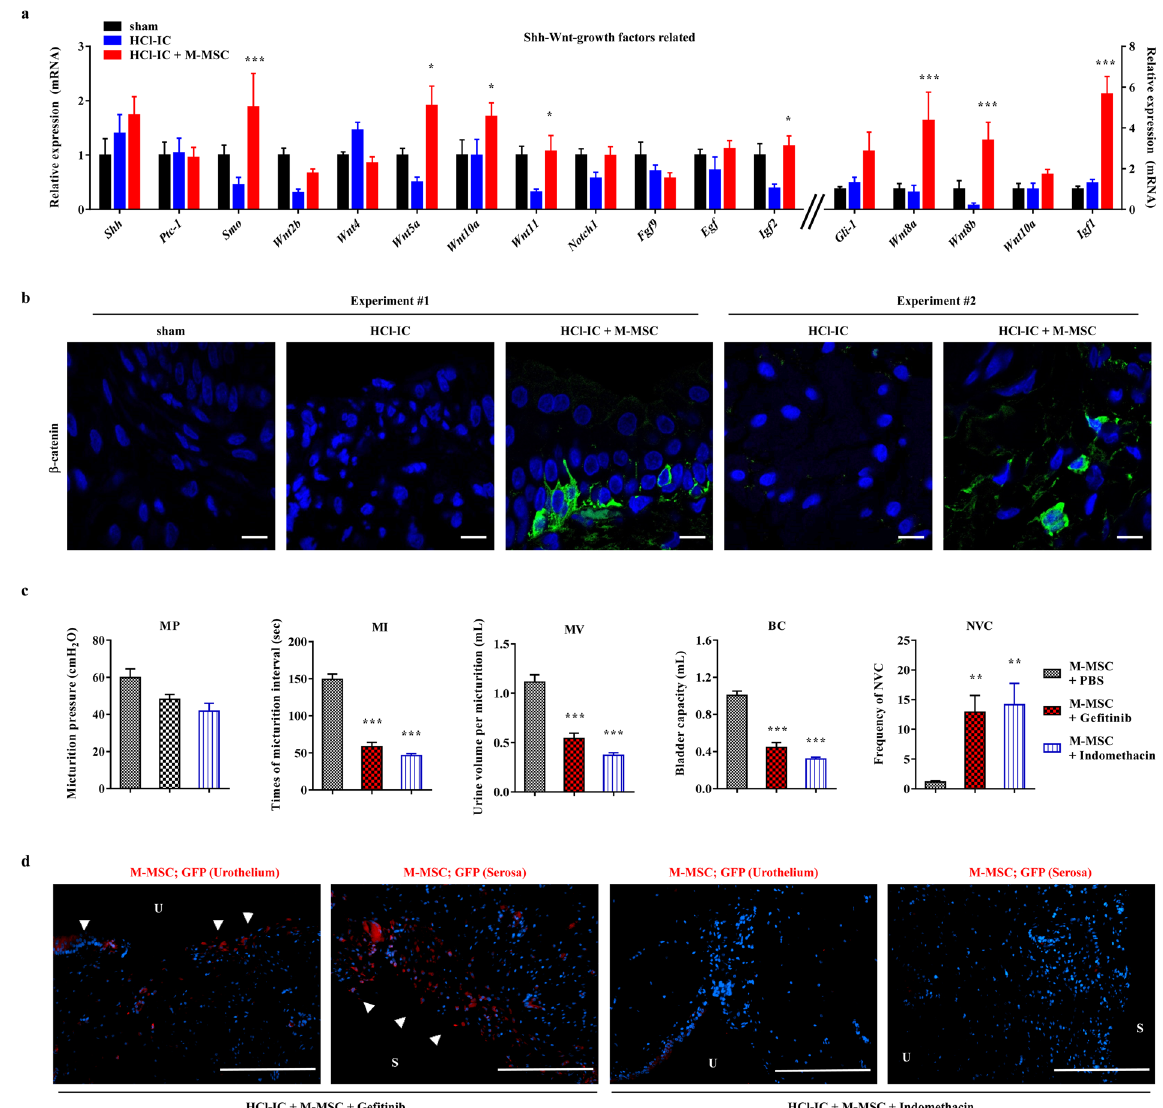
Figure 5. Central role of Wnt and IGF signaling activity on therapeutic effect of M-MSCs. ( a , b ) RQ-PCR analyses of expression levels of Shh , Wnt , and downstream growth factors ( a ) and representative confocal micrographs (magnification × 1,000, scale bar = 10 μ m) for immunofluorescence staining of β -catenin protein ( b ) in the bladder tissues of the indicated groups 1 week after the injection of 1 × 10 6 M-MSCs or PBS vehicle into HCl-IC animals. Expression is presented as % Gapdh (n = 10). ( c ) Quantitative data of bladder voiding parameters in rats (from 8 independent animals per group) at 1 week after the injection of 1 × 10 6 M-MSCs into HCl-IC animals in the absence or presence of indomethacin (Wnt blocker) or Gefitinib (IGF-mediated signaling inhibitor) intervention. All data are presented as the mean ± SEM, ** p < 0.01, *** p < 0.001 compared to the HCl-IC group with Bonferroni post-test. ( d ) Detection of M-MSCs stably expressing GFP (red) in the indicated rat bladders by immuostaining (magnification × 200, scale bar = 200 μ m). Nuclei were stained with DAPI (blue). Arrow heads indicate the engrafted cells. U; Urothelium, S;